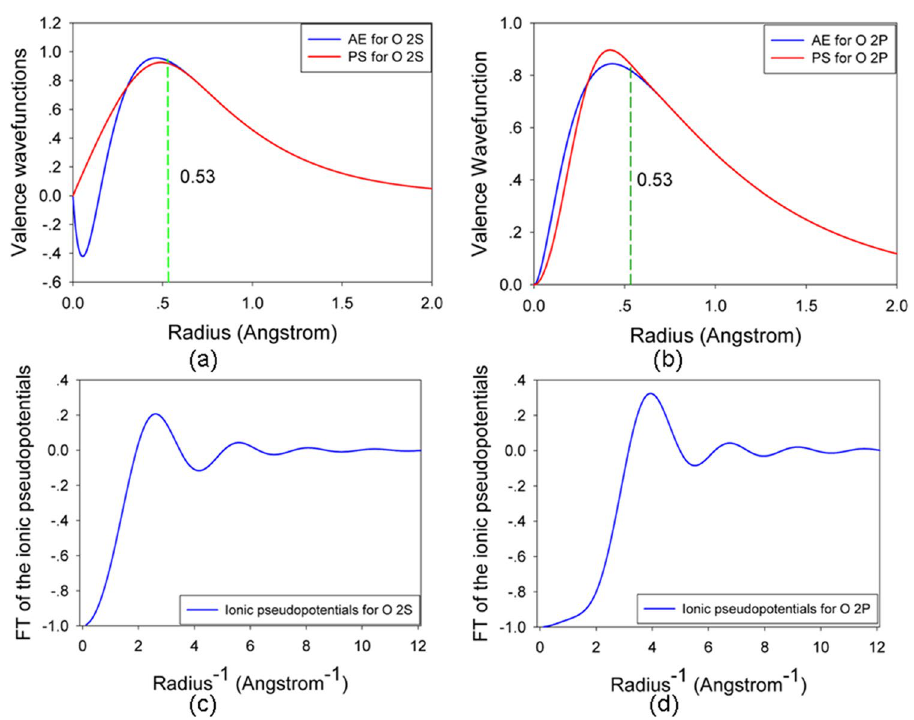
Figure 7. ( a , b ) All-electron (AE) and pseudo (PS) valence wave functions as a function of radius for oxygen 2 s and 2p orbitals; ( c , d ) Fourier transfer of the ionic pseudo potentials as a function of radius − 1 for oxygen 2 s and 2p